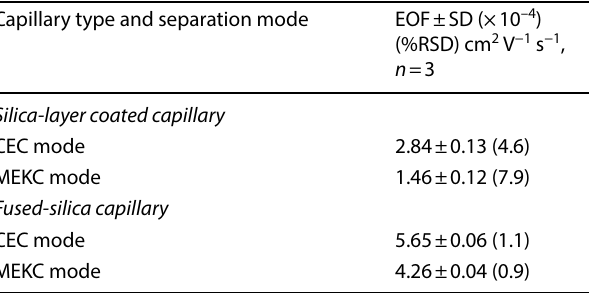
Table 3 EOF mobilities from using four separation systems: silica- layer coated capillary-CEC mode, silica-layer coated capillary-MEKC mode, fused-silica capillary-CEC mode, and fused-silica capillary- MEKC mode Capillary type and separation mode